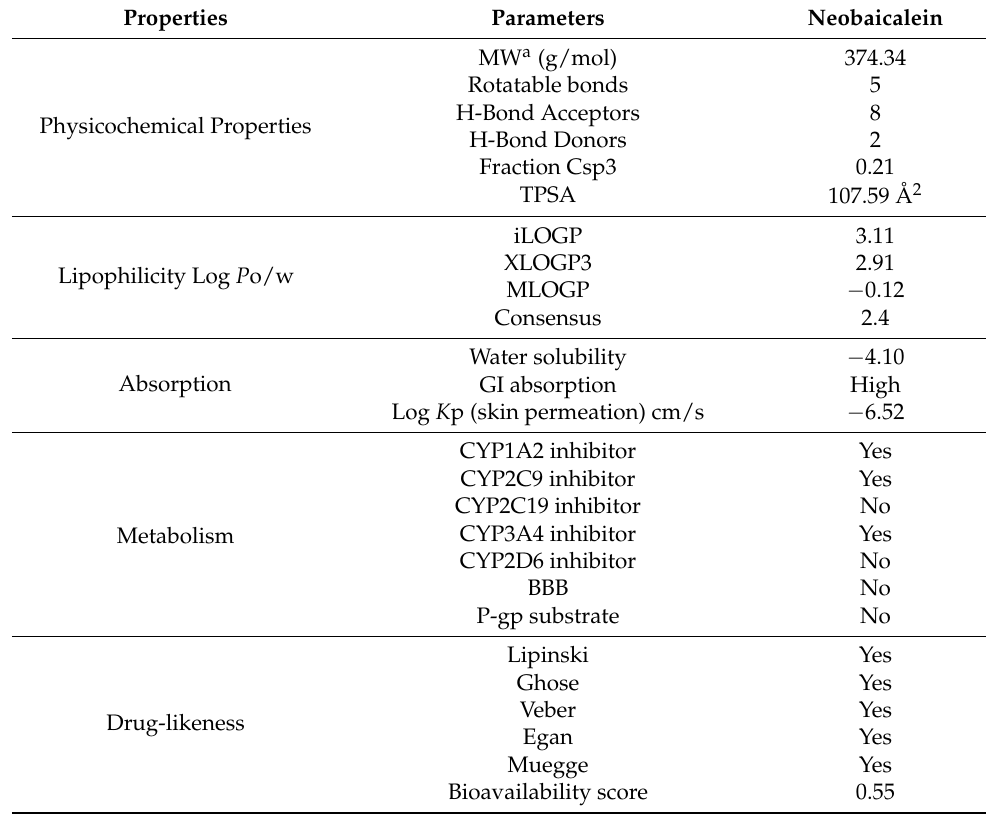
Table 1. ADME properties and drug-likeness of